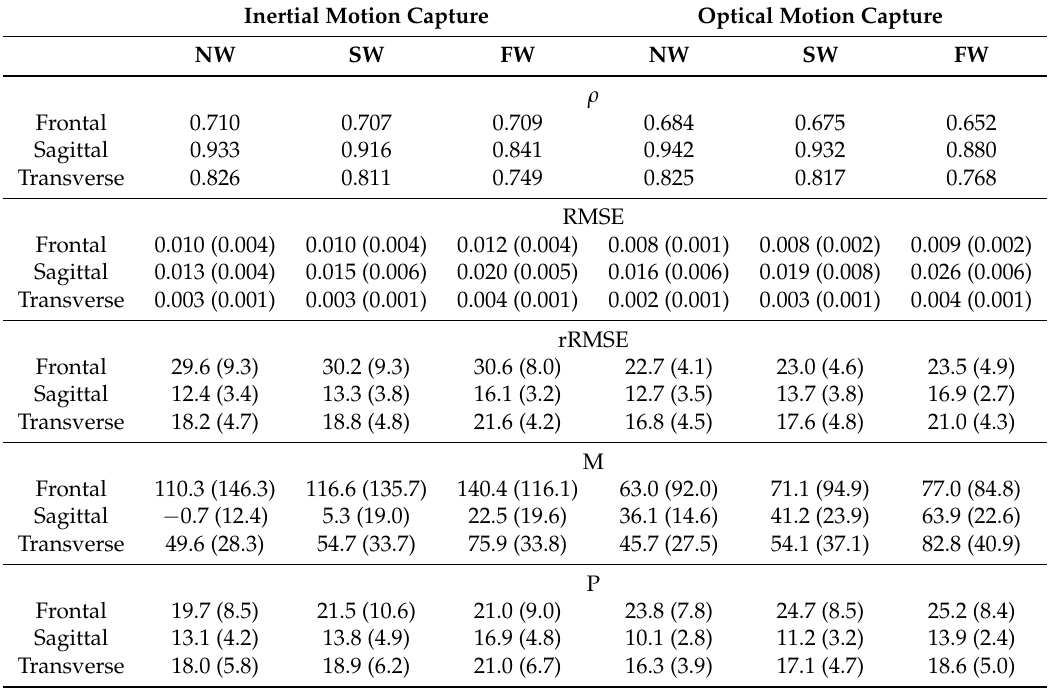
Table 5. Comparison of ground reaction moments (GRM) estimated from inertial motion capture and optical motion capture versus force plate measurements. ρ = Pearson’s correlation coefficient, RMSE = root mean square error in Nm/BW * BH, rRMSE = relative root mean square error (%), M = curve magnitude difference (%) and P = phase difference (%). Results are analyzed during normal (NW), slow (SW) and fast walking (FW) for the decomposed right and left GRM.